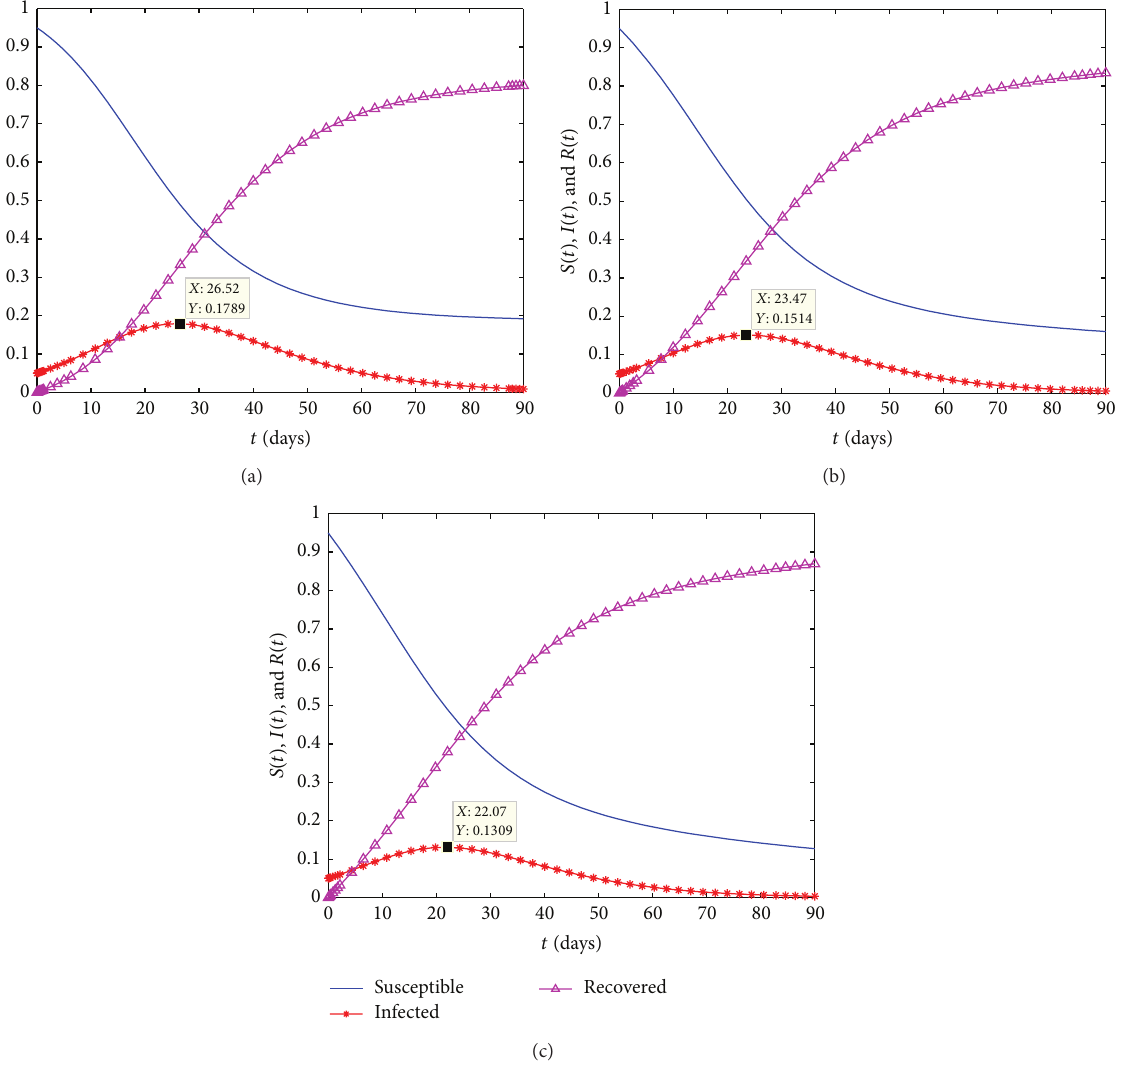
Figure 6: A solution to the SIR model (6) with 𝛽 = 0.2 , 𝜇 = 0.1 , 𝑆(0) = 0.95 , 𝐼(0) = 0.05 , 𝑅(0) = 0 , and different rates of vaccination: 𝜐 = 0 (a), 𝜐 = 0.005 (b), and 𝜐 = 0.01